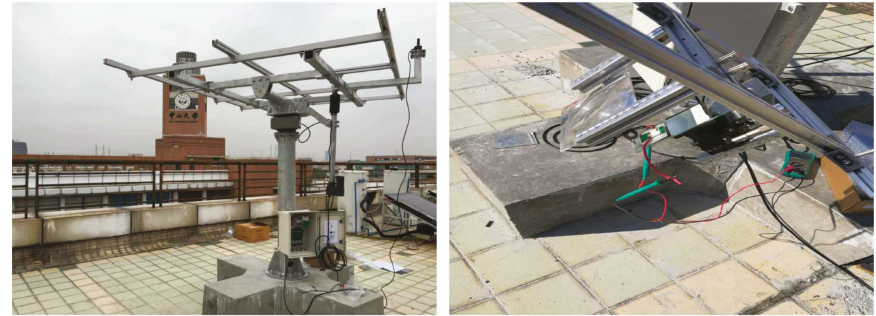
Figure 11: Experimental platform and